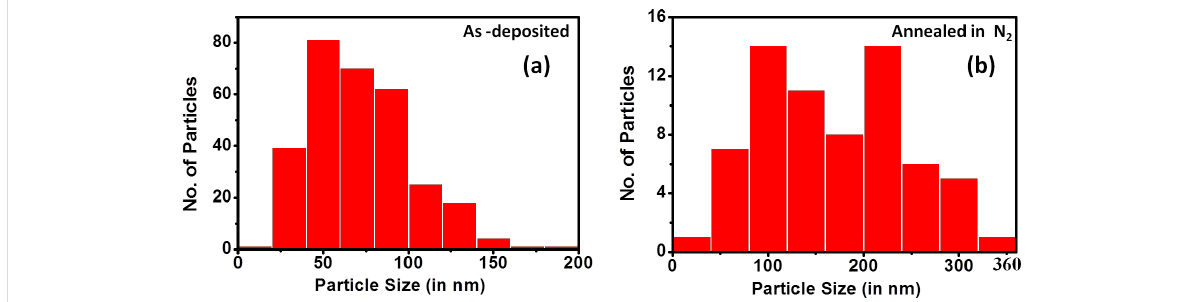
Figure 7: Cu nanoparticle distribution on a Si surface for (a) as-deposited and (b) annealed in nitrogen samples. A summary of the distributions is presented in Table 2.